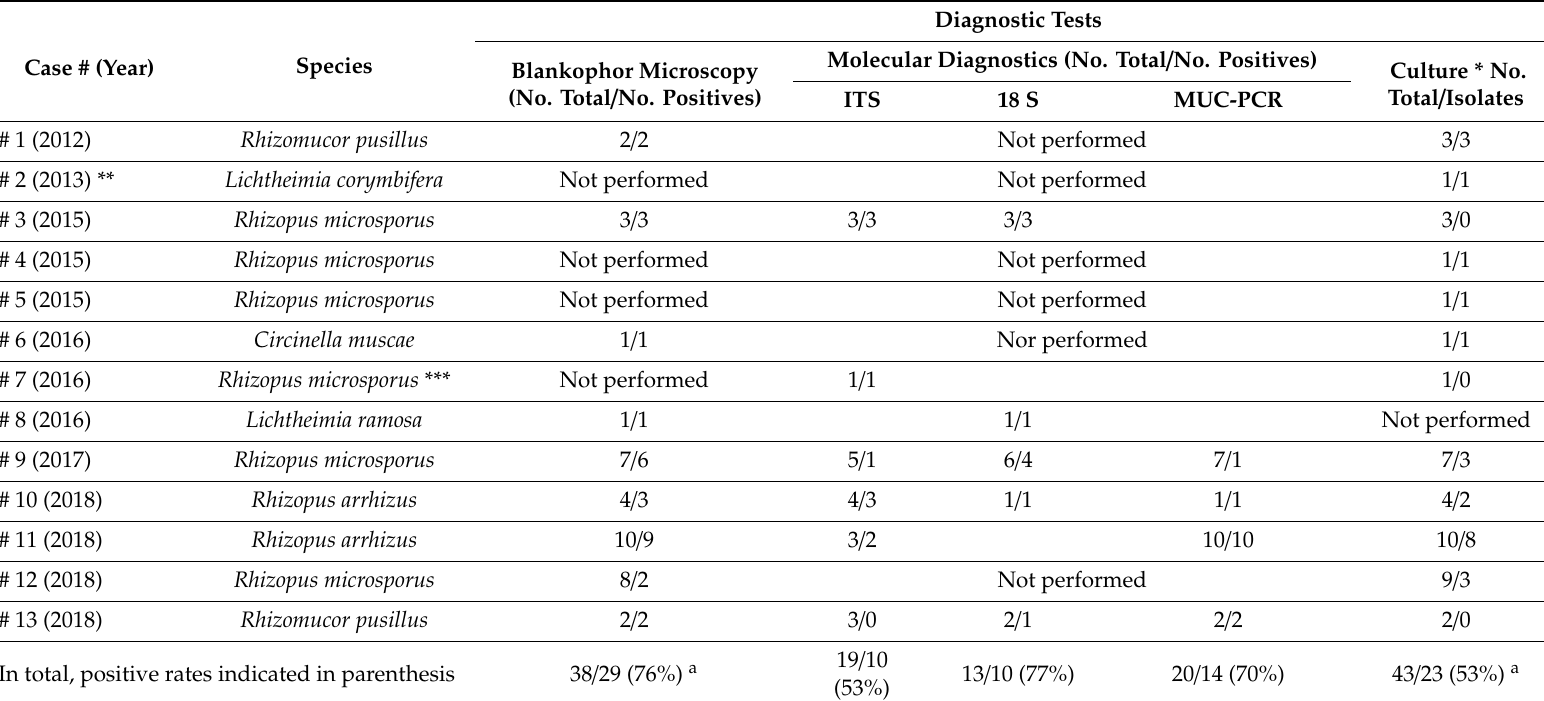
Table 3. Diagnostic tests performed within the first 7 days from proven